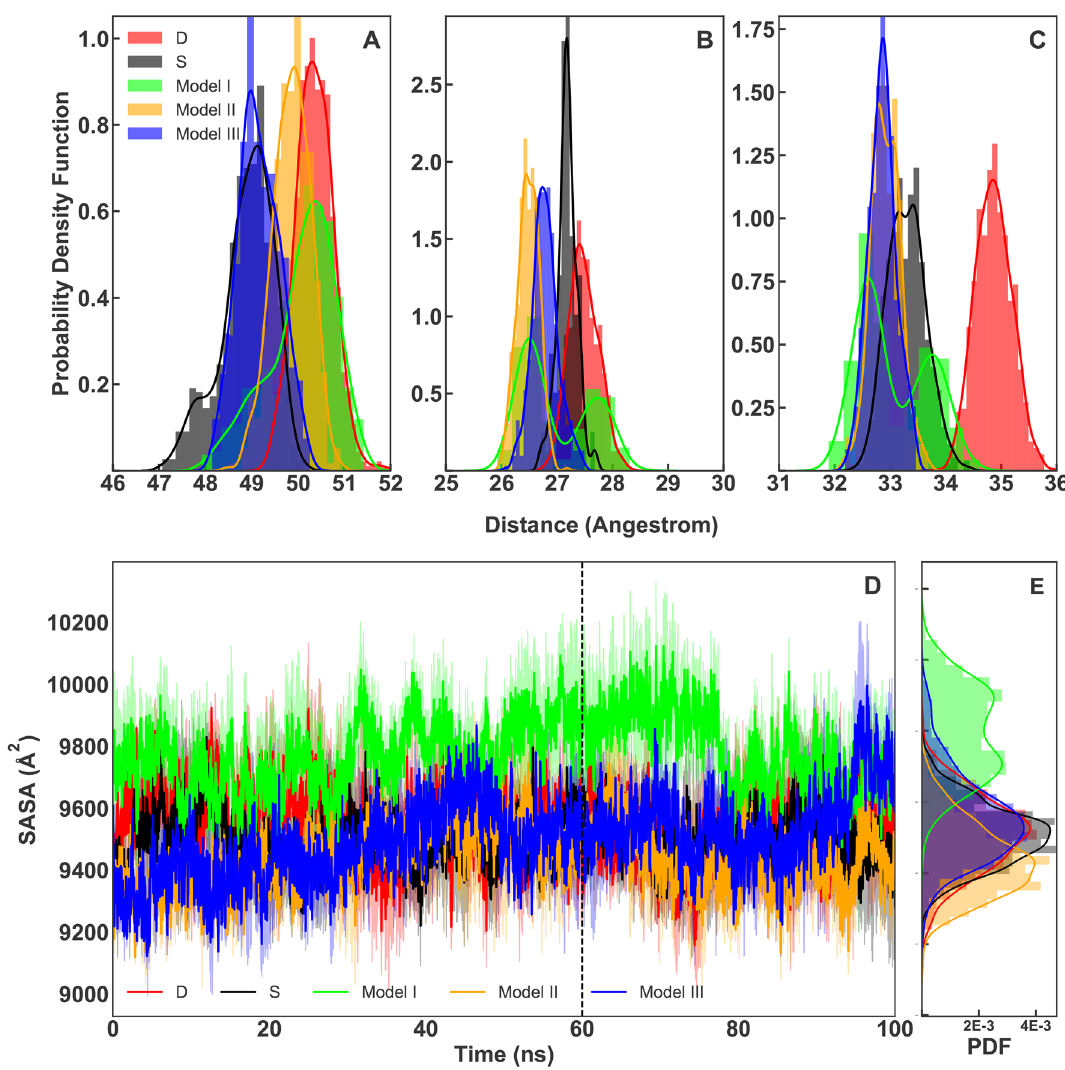
Figure 9. ( A ) PDF of RBD to ACE2 averaged distance distribution with a histogram and maximum likelihood gaussian distribution fit: calculated from all replicate of each system and are represented in black, lime, orange and blue for models S and I–III respectively. PDF of model D is shown in red. ( B ) PDF of RBD to H1 averaged distance distribution with a histogram and maximum likelihood gaussian distribution fit: calculated from all simulations of each system and represented in black, lime, orange and blue for models S and I–III respectively. PDF of model D is shown in red. ( C ) PDF of RBD to H2 averaged distance distribution with a histogram and maximum likelihood gaussian distribution fit: calculated from all simulations of each system and represented in black, lime, orange and blue for models S and I–III respectively. PDF of model D is shown in red. Sampling were done from the last 40 ns of simulations. ( D ) SASA plots of RBD-ACE2 interface that calculated from all simulations of each system and represented in black, lime, orange and blue for models S and I–III respectively. The SASA plot of model D is shown in ACE353-RBD496, ACE34-RBD417, ACE34-RBD453, ACE37-RBD505, ACE42-RBD446, ACE353-RBD502), there is a noticeable increase in the peak location compared to other systems (Fig. 10). In most of the interacting pairs, the O-glycosylated models with elongated oligosaccharides show the smallest peak values (Fig. 10). In two of the interacting pairs (ACE353-RBD498, ACE31-RBD493 and ACE355-RBD500) model D shows a decrease in the distribution peaks (Fig. 10). The noticeable increases and decreases in model D plots for different interacting pairs show the system’s flexibility and weakened RBD-ACE2 interactions. Among the O-glycosylated models, I is the only system that present increased peak values for ACE38-RBD449 and ACE42-RBD446 interacting pairs. Model I was shown to be the most flexible O-glycosylated model (Fig. 3). Due to the flexibility that is added to the system by the short two-units glycan that is unable to form contacts with neighbouring residues in the interface in a manner that occurs for models II and III simulations (Fig. 8). The binding free energy between the RBD and ACE2 also shows that the interaction is most favorable upon O-glycosylation in models II and III with longer attached glycans (Fig. 11). The binding free energies between